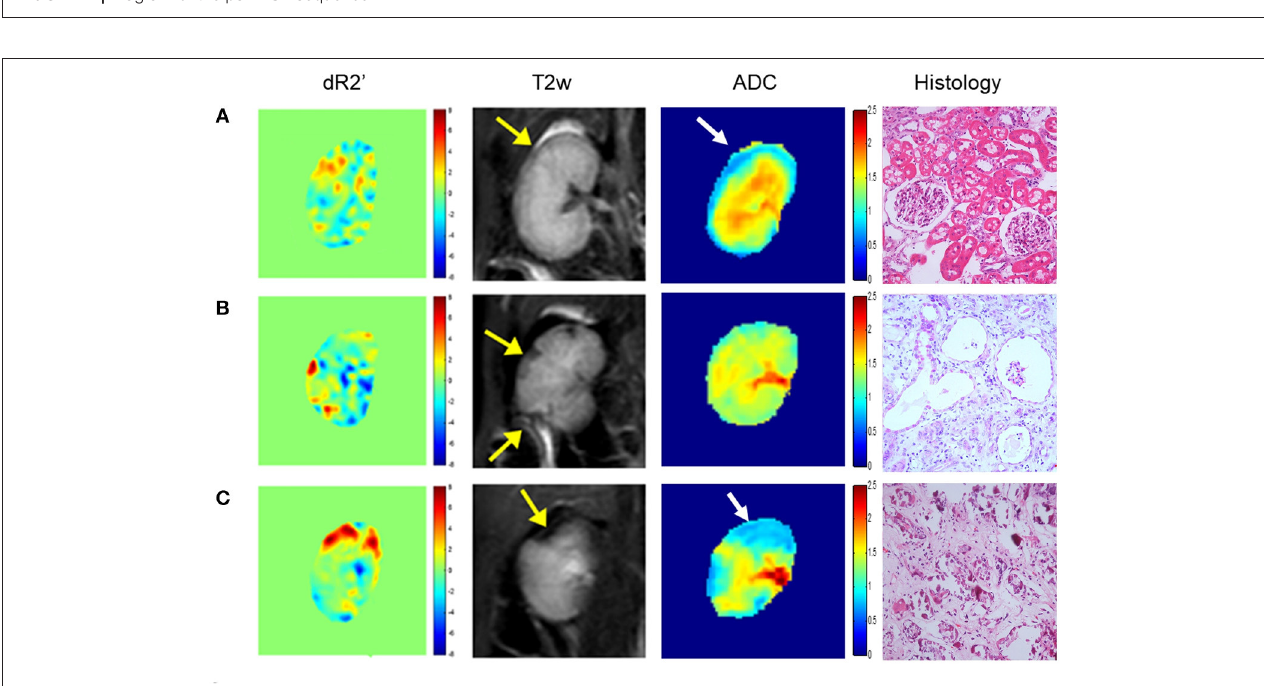
FIGURE 2 | Representative dR2’ maps, T2w maps, ADC maps, and histological results of mild (A) , moderate (B) and severe (C) AKI groups. The dR2’ and ADC maps are acquired within 1h after the embolization procedure. The T2w maps and histological results are acquired one month after the procedure. The yellow and white arrows indicate the most affected areas in T2w and ADC images. In the histological images, mild vacuole degeneration occurs in a few renal tubular epithelial cells in the mild case. Atrophy, ischemia and sclerosis of glomerulus and cellular debris are observed in the moderate case. Necrosis and abscission of the renal tubular epithelial cells is observed, and the basement membrane is exposed in the severe case. Atrophy, ischemia and sclerosis of glomerulus can also be observed.